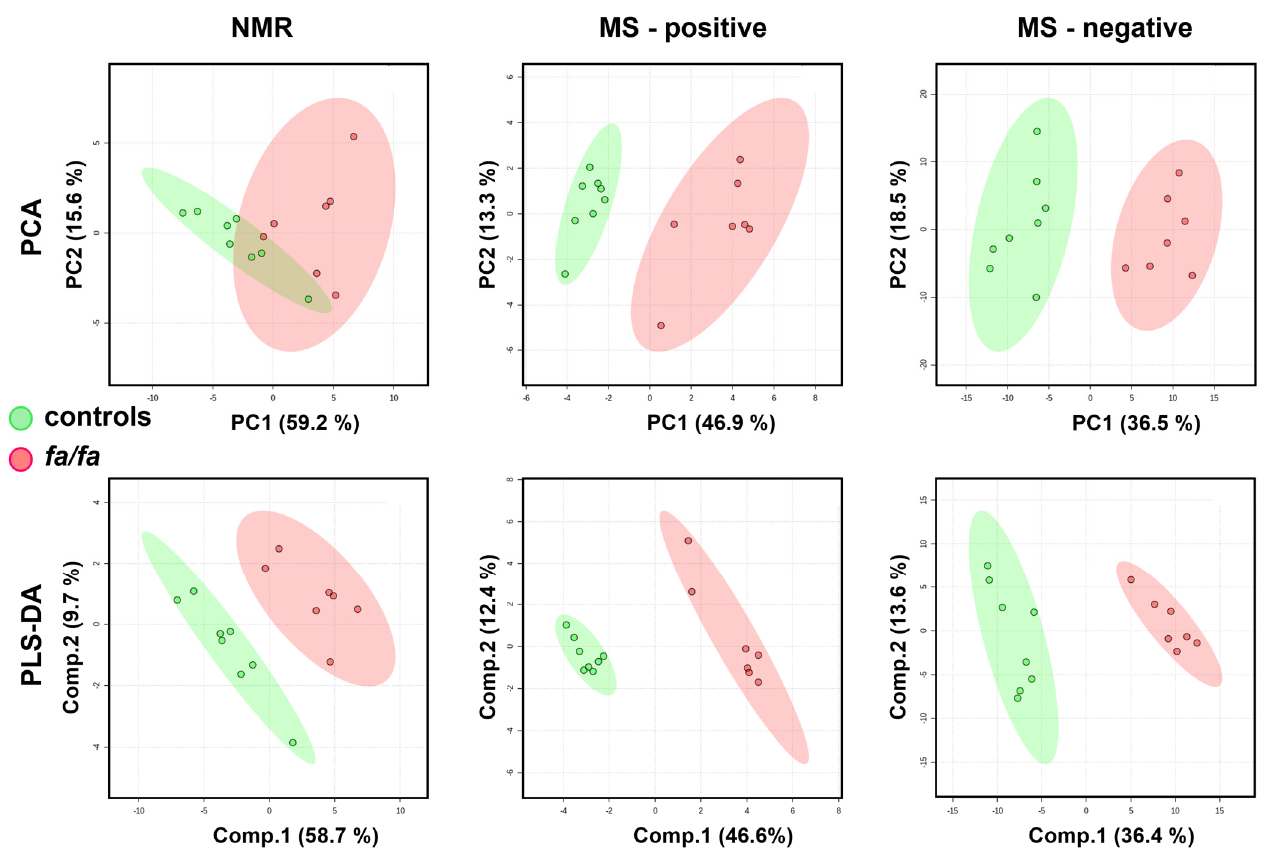
Figure 5. Score plots of PCA and PLS-DA models of serum from fa / fa and control rats (at 40 weeks of age) based on NMR and MS data. The LOOV results for 3 principal components: accuracy = 1, R2 = 0.98, Q2 = 0.89 for NMR-based; accuracy = 1, R2 = 0.99, Q2 = 0.96 for positive-MS-based; accuracy = 1, R2 = 0.99, Q2 = 0.92 for negative-MS-based. Fa / fa group is marked in red, control group in green.